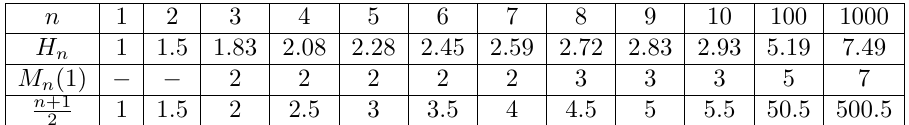
Table 1: Modes for s = 1 and related